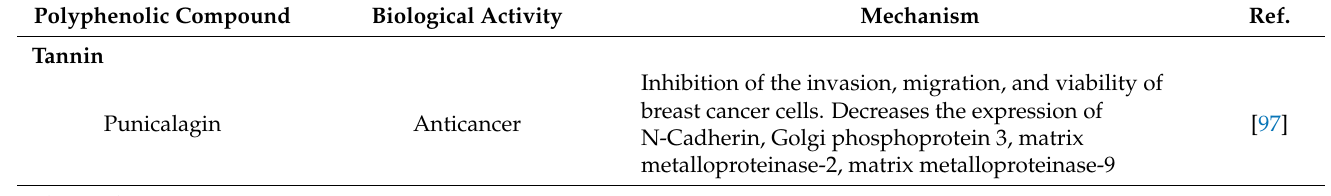
Table 2. Beneficial health effects of flavonoid and non-flavonoid phenolic compounds found in edible and non-edible parts of several tropical